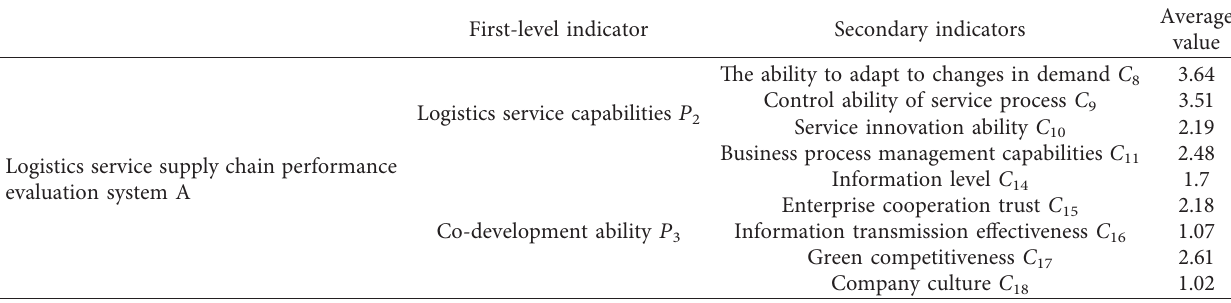
Table 3: Statistical values of qualitative indicators for the performance evaluation of S enterprise logistics service supply chain.